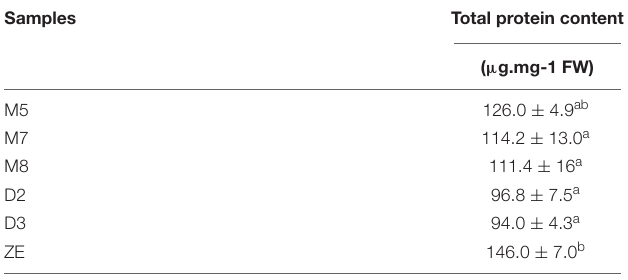
Values are means of three biological repetitions ± SE. Significant differences at P < 0.05 are indicated in different letters.